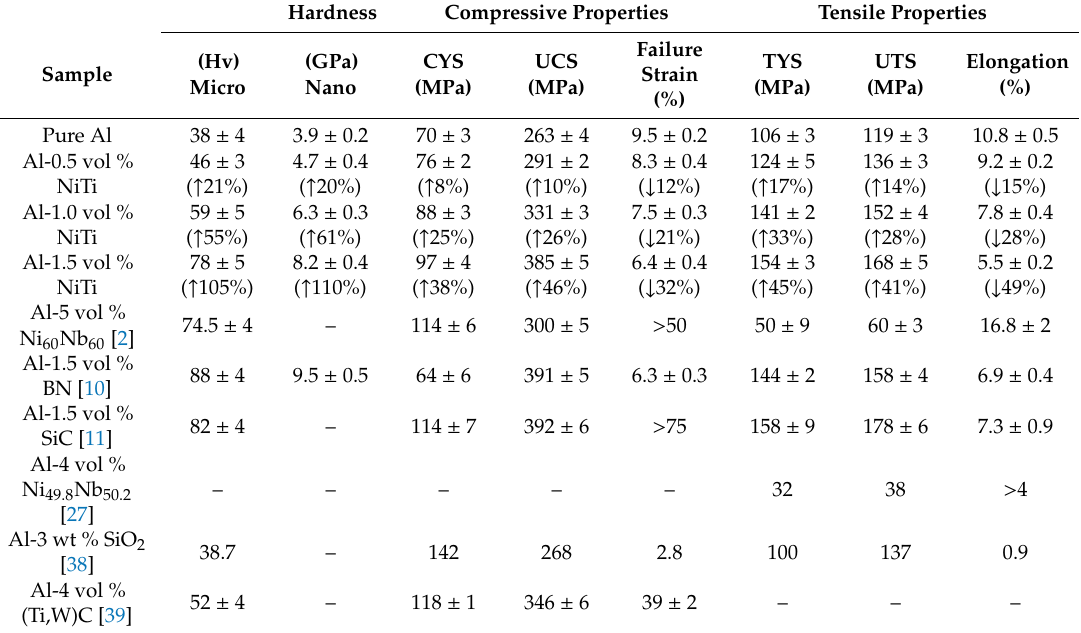
Figure 3. ( a ) Vickers microhardness, ( b ) nano hardness, and ( c ) compressive properties of extruded Al-NiTi nanocomposites as a function of NiTi content. Table 1. Comparison of mechanical properties of Al–NiTi nanocomposites with other studies. Hardness Compressive Properties Tensile